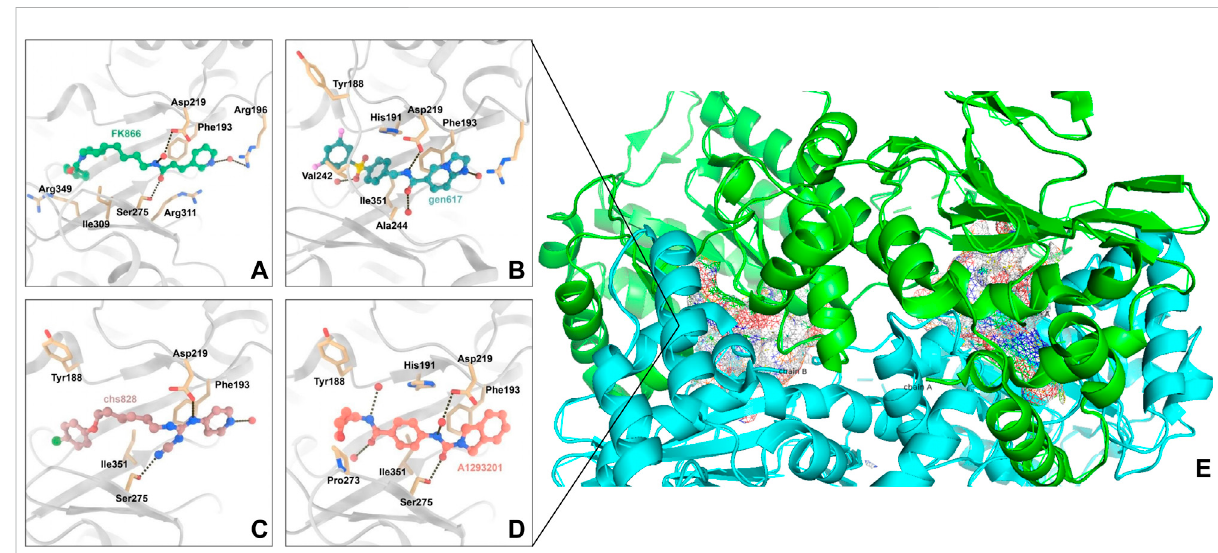
FIGURE 2 Interaction of NAMPT with inhibitory compounds: (A) . Interaction of NAMPT with the speci fi c inhibitor FK866. (B) . Interaction of NAMPT with speci fi cinhibitorGEN617. (C) .InteractionofNAMPTwithspeci fi cinhibitorCHS828. (D) .InteractionofNAMPTwithA1293201. (E) .X-raycrystalimage of NAMPT, the enzyme has two symmetrical binding